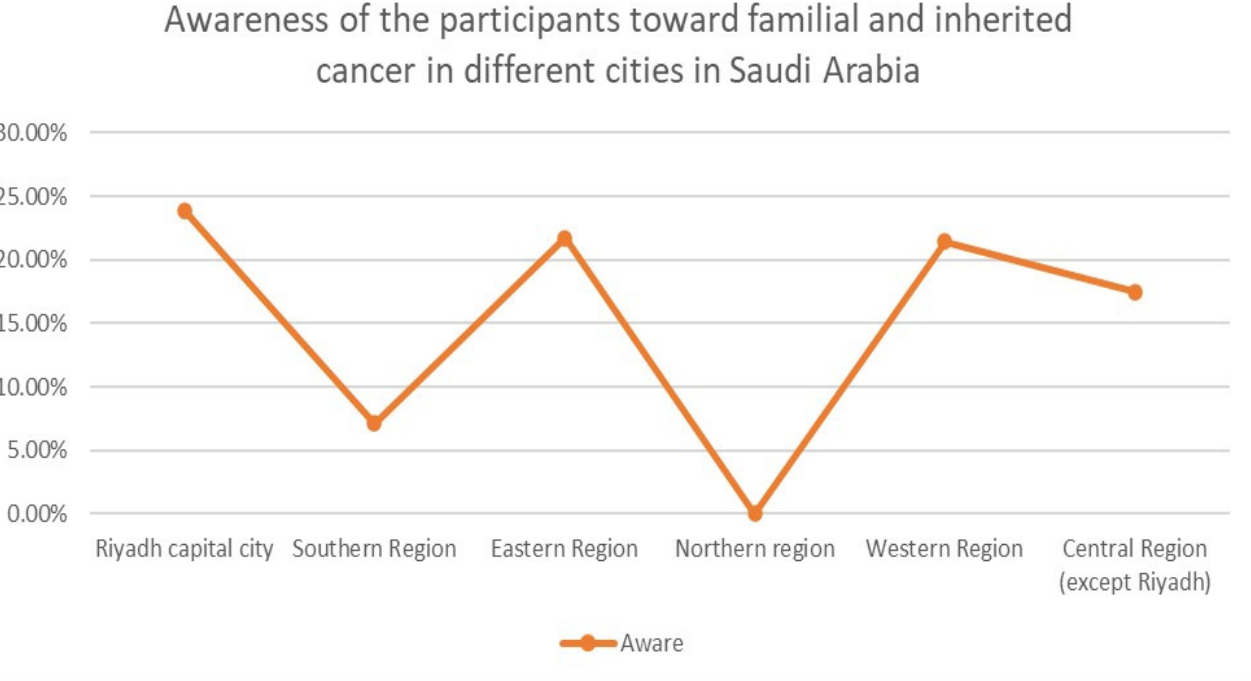
Figure 1. Awareness of the participants toward familial and inherited cancer in different regions in Saudi Arabia. X axis: main regions in Saudi Arabia. Y axis: percentage of the awareness toward familial and inherited cancer.